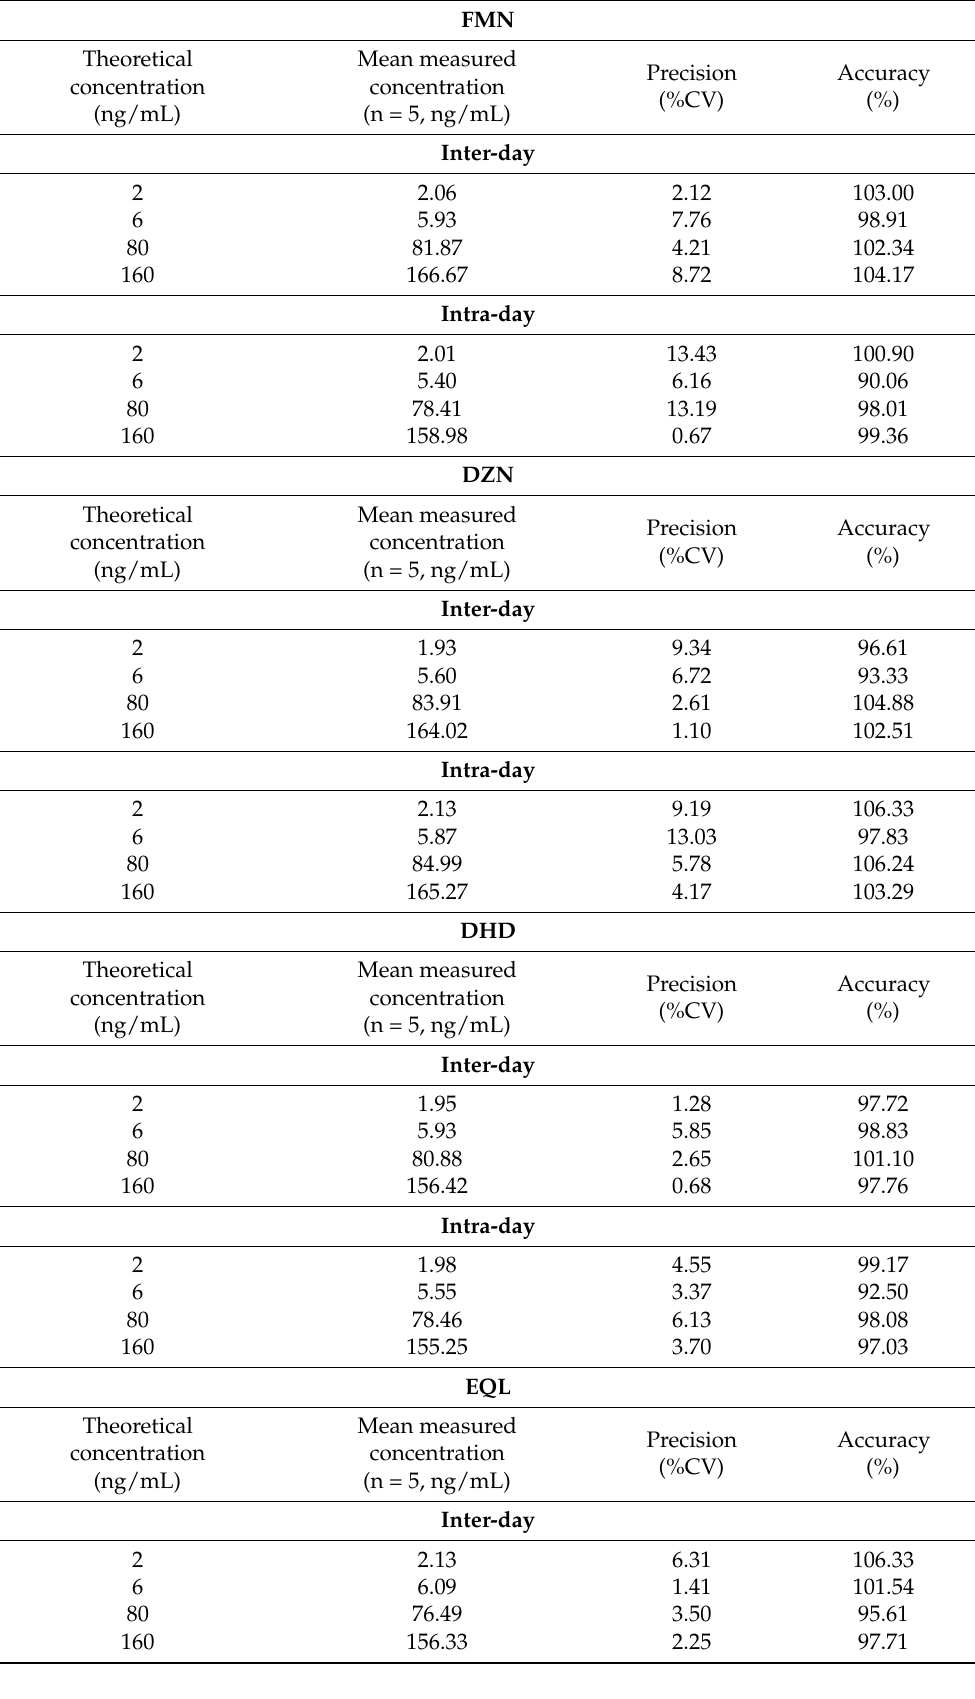
Table 1. The precision and Accuracy of the determination of FMN, DZN, DHD and EQL in rat